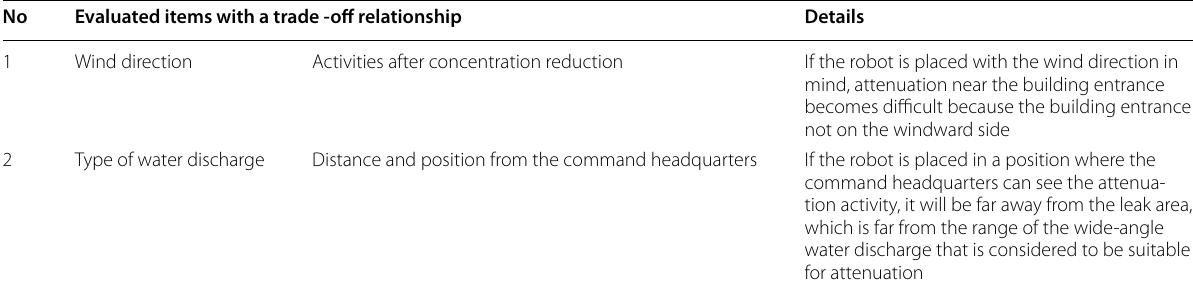
Table 18 Evaluated items with a trade-off relationship during the attenuation activities No Evaluated items with a trade ‑off